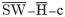
Recovery results of the four estimation methods for additional random network SW¯-H¯-c (with the high density of 3%).True −− network metrics indicated where appropriate. The dotted line ⋯ shows the level of the false positive rate, above which the absolute number of false positive edges even exceeds the absolute number of edges in the true network.